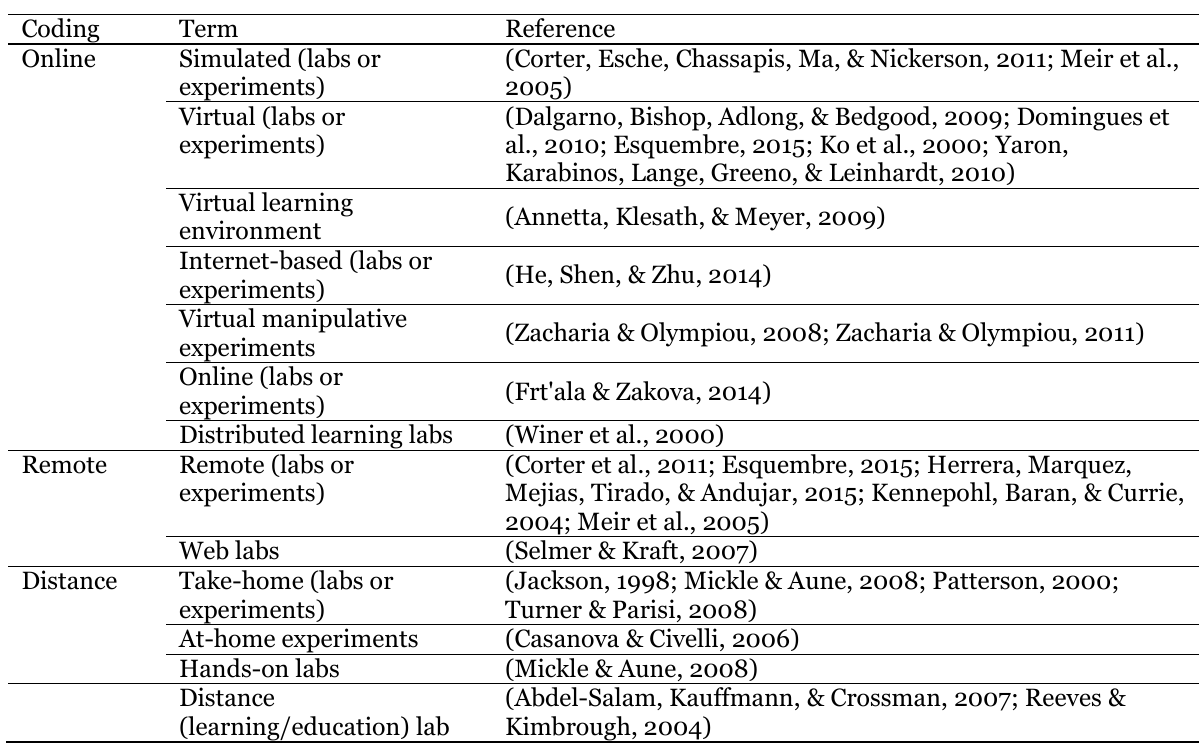
Examples of Terminology for Non-traditional Labs in Literature